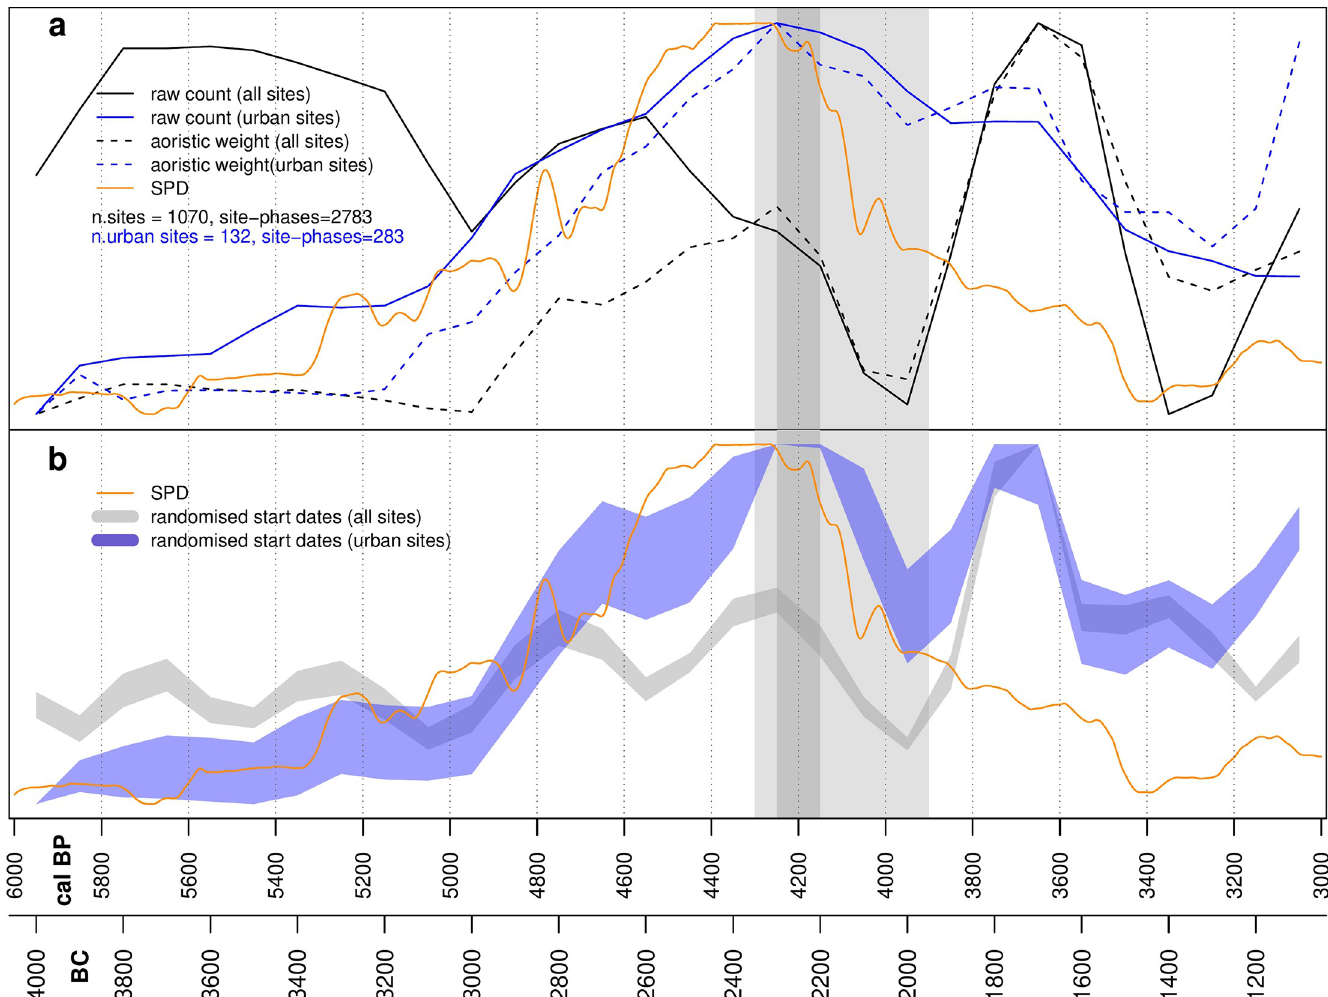
Fig 7. Comparison of SPDs, urban and rural settlement. a: SPD, raw counts and aoristic weights for urban and all sites. b: SPD and randomized start dates for urban and all sites.